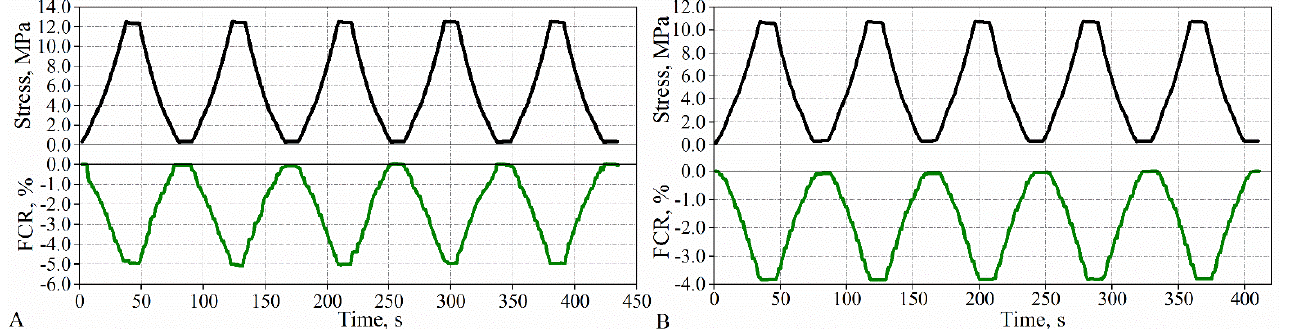
Figure 9. Relationship between FCR and stress under cyclic loading for composites with graphite content: ( A ) 2 wt% and ( B ) 3 wt%.